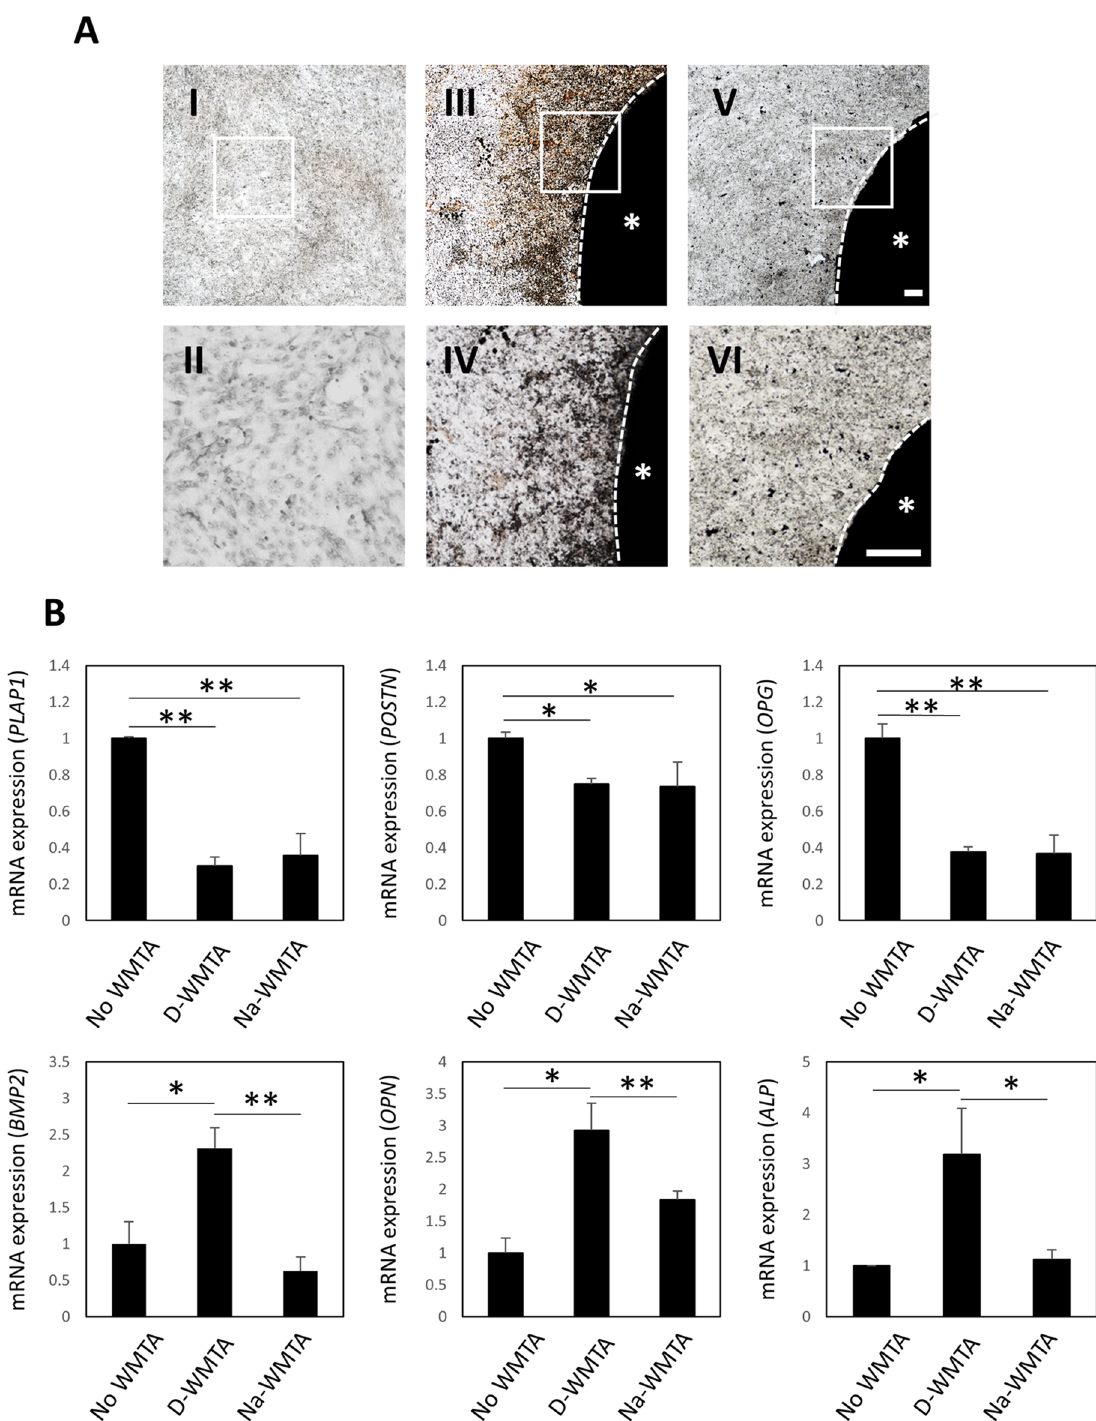
Figure 5. Effects of WMTA discs immersed in NaOCl on osteoblastic differentiation of line 1–17 cells. ( A ) Von Kossa staining images of line 1–17 cells. This line was cultured in No WMTA (I and II), CM with D-WMTA (III and IV), or CM with Na-WMTA (V and VI) for 28 days. (II, IV, and VI) show higher magnification images of the white boxes in (I, III, and V), respectively. Asterisks indicate WMTA discs and white dotted lines indicate their edges. Experiments were performed in quadruplicate. Representative data are shown. Bars = 100 µm. ( B ) Quantitative RT-PCR analysis of PDL-related genes ( PLAP1 , POSTN , and OPG ) and osteoblast-related genes ( BMP2 , OPN , and ALP ) in line 1–17 cells cultured in No WMTA, CM with D-WMTA, or CM with Na-WMTA. PLAP1, Periodontal ligament-associated protein 1; POSTN, Periostin; OPG, Osteoprotegerin; BMP2, Bone morphogenetic protein 2; OPN, Osteopontin; ALP, Alkaline phosphatase. These gene expression values were normalized to Beta actin ( β-act ) and No WMTA. *P < 0.05, **P <